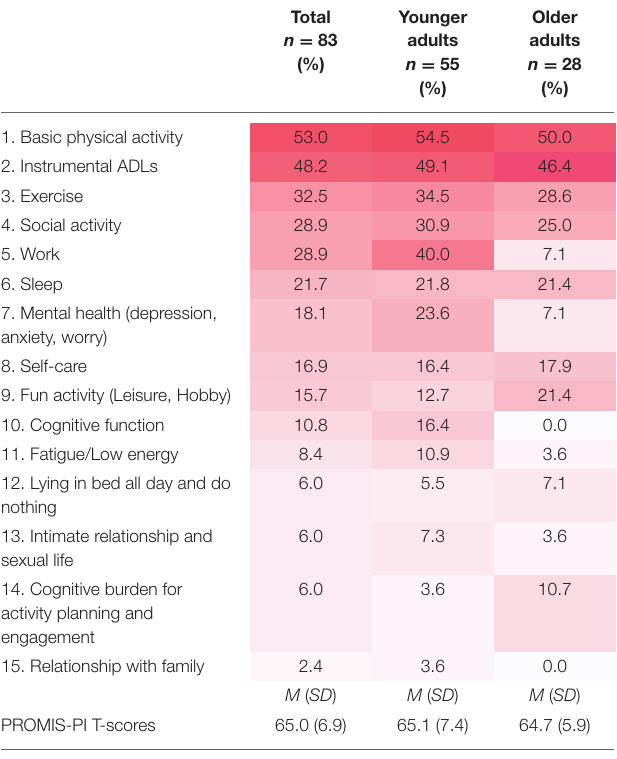
TABLE 3 | Comparing the three major areas of pain impact between younger and older adults with chronic